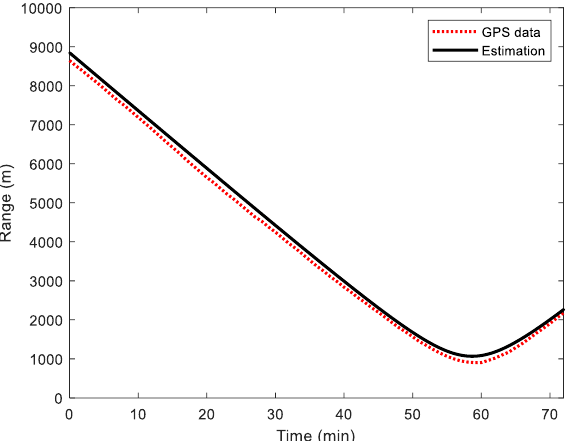
Figure 13. Comparison of moving source range from GPS data and from estimated radial velocity.